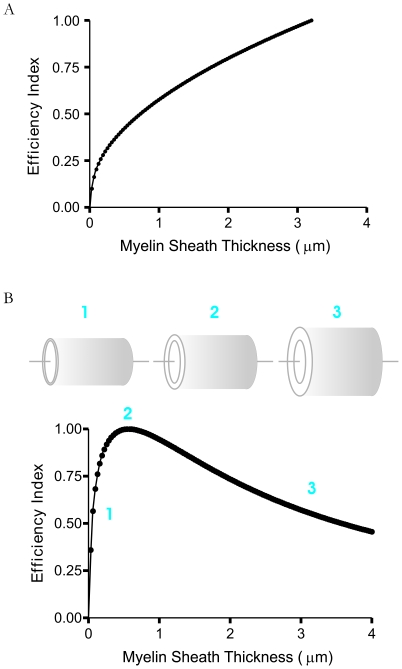
The model can predict an optimized level of myelination for a given axon.A: Relative efficiency index with increasing lamellae (i.e. increasing sheath thickness) without volume as a constraint (i.e., δ = 0). A global optimum does not exist. B: Top, a schematic illustrating a 2 µm inner diameter (di) axon with an increasing (1→3) myelin sheath thickness; where the total myelin sheath thickness equals the difference between the outer (do) and inner diameters (i.e., do-di). Bottom, relative efficiency index for different myelin sheath thicknesses. “2” represents the level of “optimized” (i.e, maximal efficiency) myelination for this particular axon. “1” and “3” illustrate that lower or higher levels of myelination provide a less efficient myelo-architectural design. Here volume is a constraint (δ = β = 1).